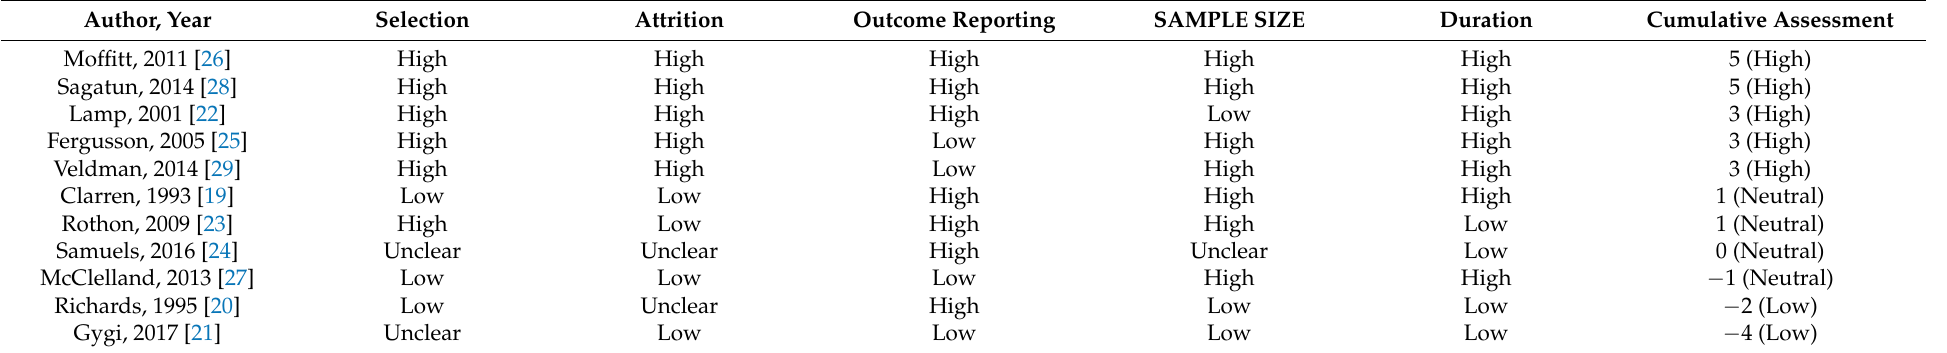
Table 2. Study quality